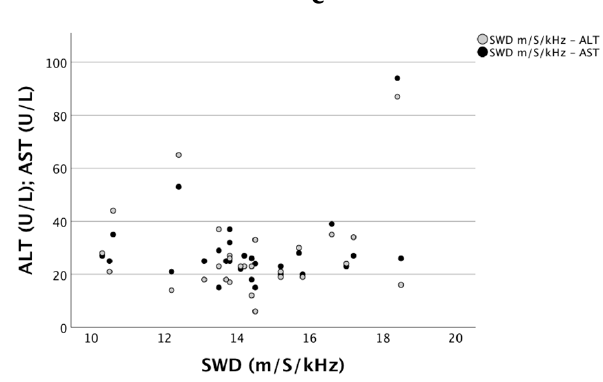
Figure 3. ( a , b ): Spearman’s correlation of TE (kPa) and thrombocytes/nl and 2D-SWE (kPa). ( c , d ): Spearman’s correlation of the spleen length (mm) and thrombocytes/nL and SWD (m/S/kHz) All p -values < 0.05. ( e ): no correlation between ALT/AST and SWD. Abbreviations: ALT: alanine aminotransaminase; AST: aspartate aminotransaminase; GGT: gamma- glutamyl transpeptidase; SWE: shear wave elastography; SWD: shear wave dispersion; TE: transient elastography.